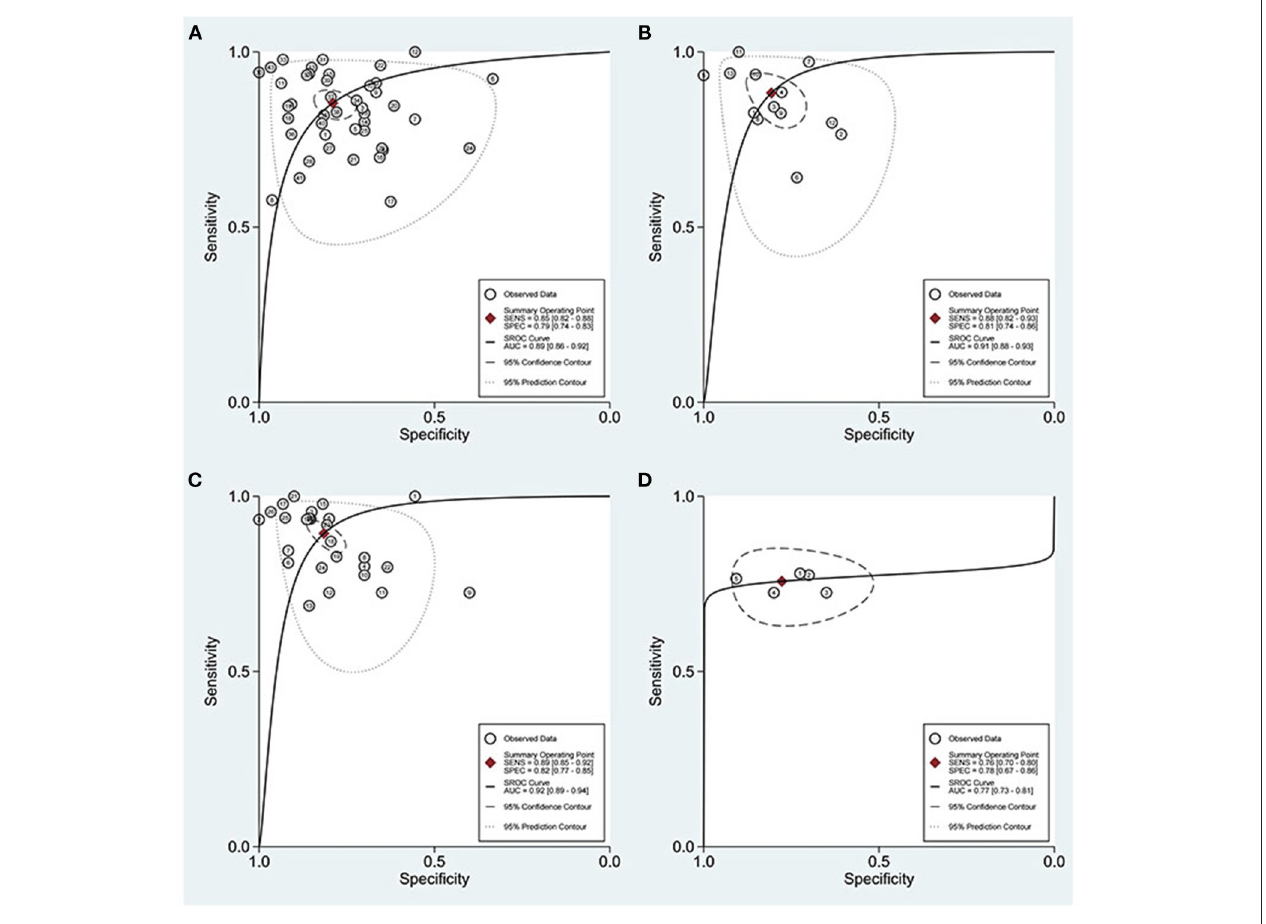
FIGURE 8 | ROC curves based on miRNAs. (A) Single miRNA; (B) miRNAs panel; (C) miRNAs detected in urine; (D)